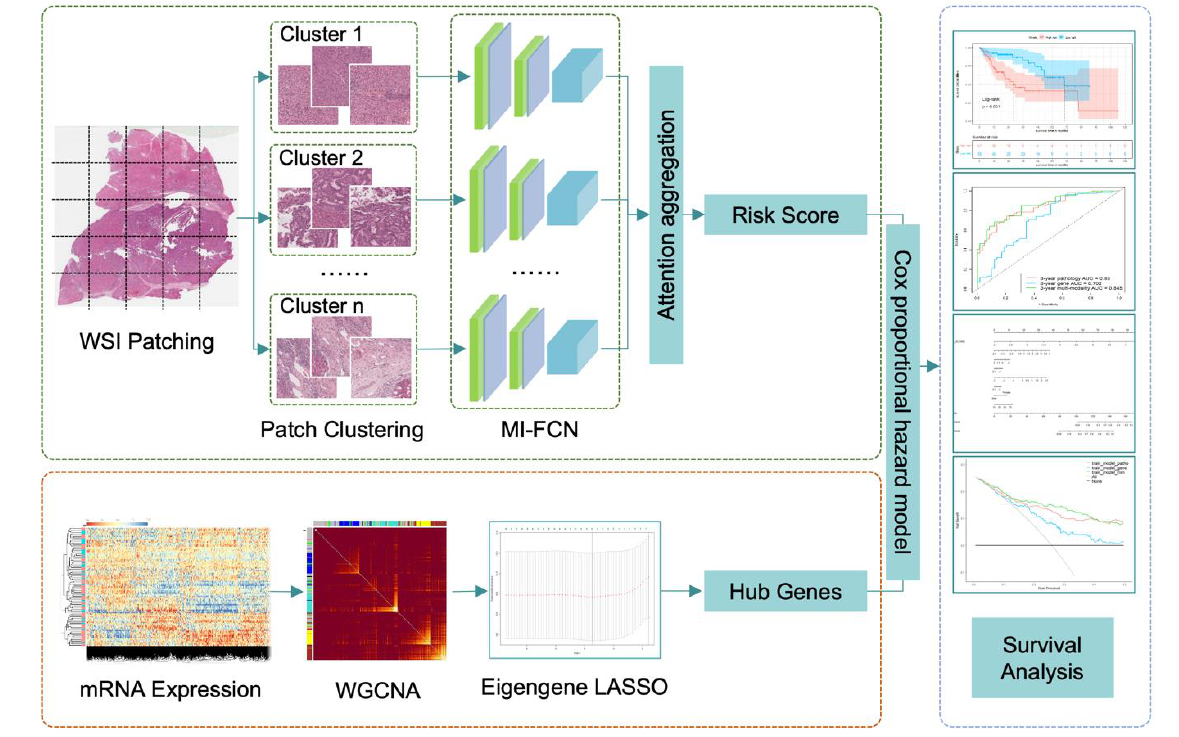
Figure 2. The workflow chart of key steps in our study. In the part of histopathology image processing, patches cut from one patient were clustered into 10 categories. Patches of each category were input into the multi-instance fully convolutional network (MI-FCN), and then, the outputs were aggregated with attention mechanism to get a risk score of the patient. In the part of mRNA-seq processing, eigengenes were obtained by weighted gene co-expression network analysis (WGCNA). Then, modules were selected by the least absolute shrinkage and selection operator (LASSO) based on eigengenes. Top hub genes of the retained modules were extracted as risk factors. In the last part, the deep learning risk score and hub genes were integrated together by Cox proportional hazard model.